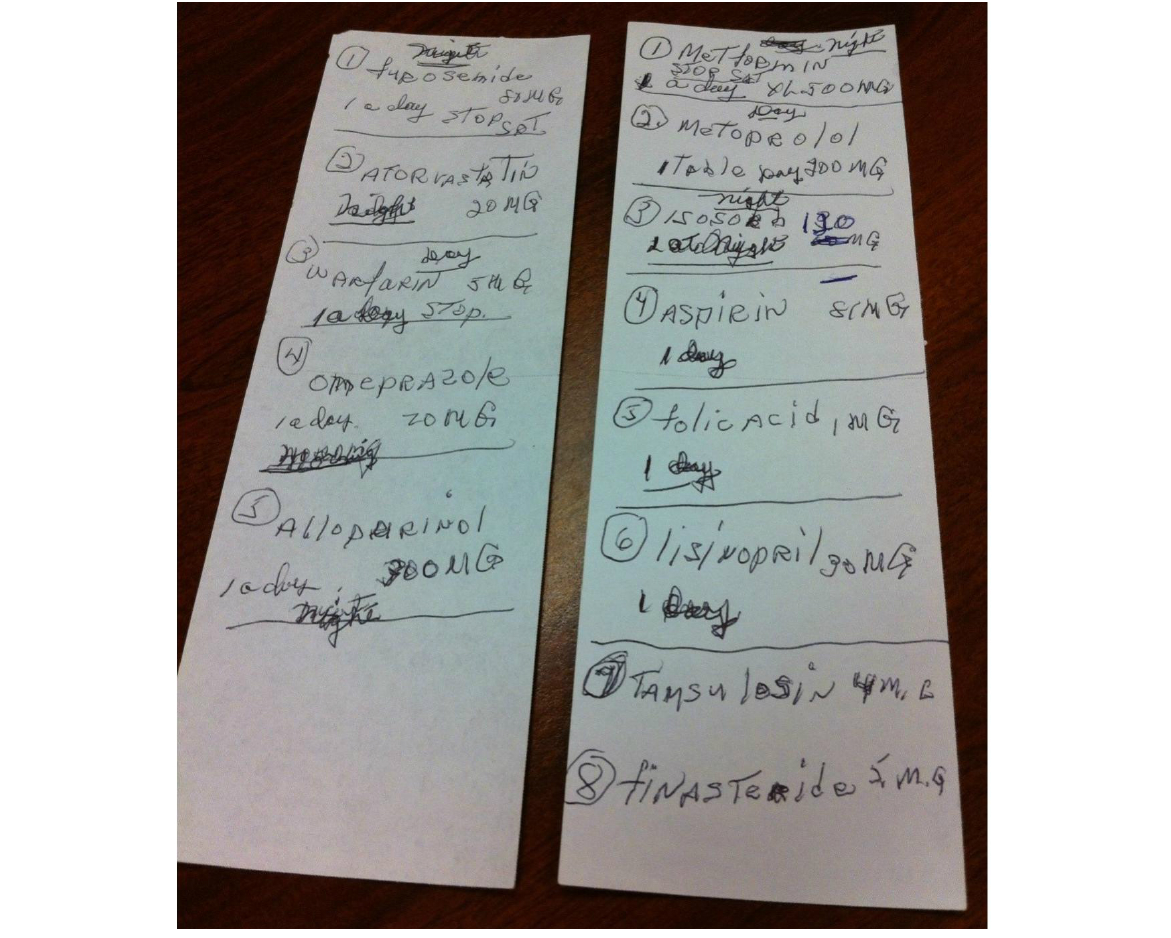
Figure 2. Portion of medication list used by a patient to track 13 medications. Originally, he had designed his system so all daytime medications were on one sheet and all nighttime medications on the other, but as the medication regimen changed, he updated his notations. The patient kept the lists in a plastic grocery bag which he brought to medical